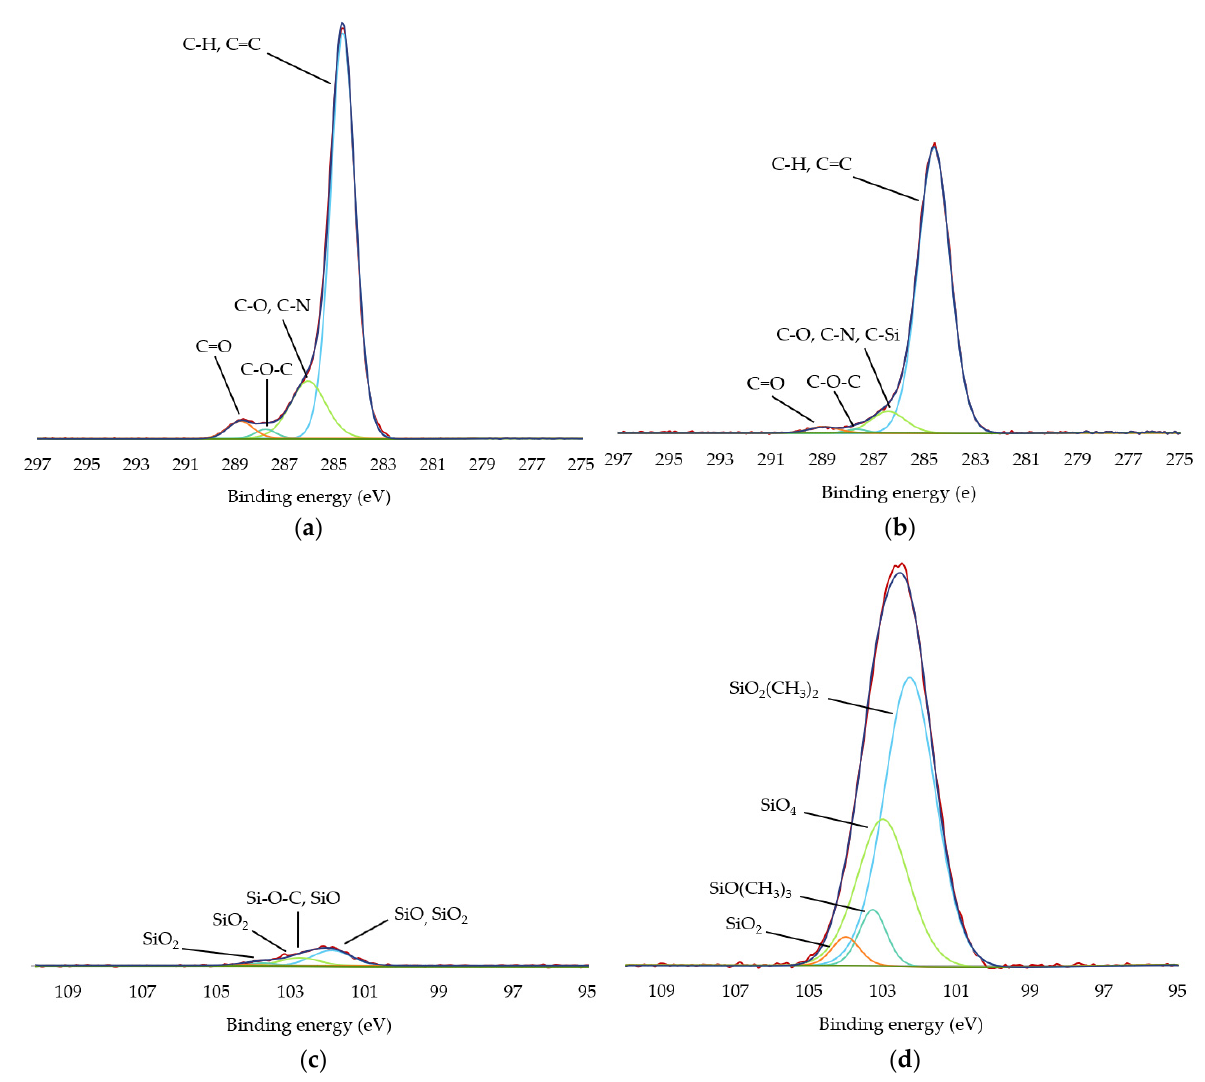
Figure 4. High-resolution peaks of HMDSO film deposited on leather. ( a ) C 1s of untreated sample; ( b ) C 1s of plasma coated leather; ( c ) Si 2p of untreated sample; ( d ) Si 2p of plasma coated leather. Table 5. Atomic percentages (at. %) of chemical species at C 1s and Si 2p peaks of the untreated and plasma coated leather determined by XPS. Untreated Leather Plasma Coated Leather